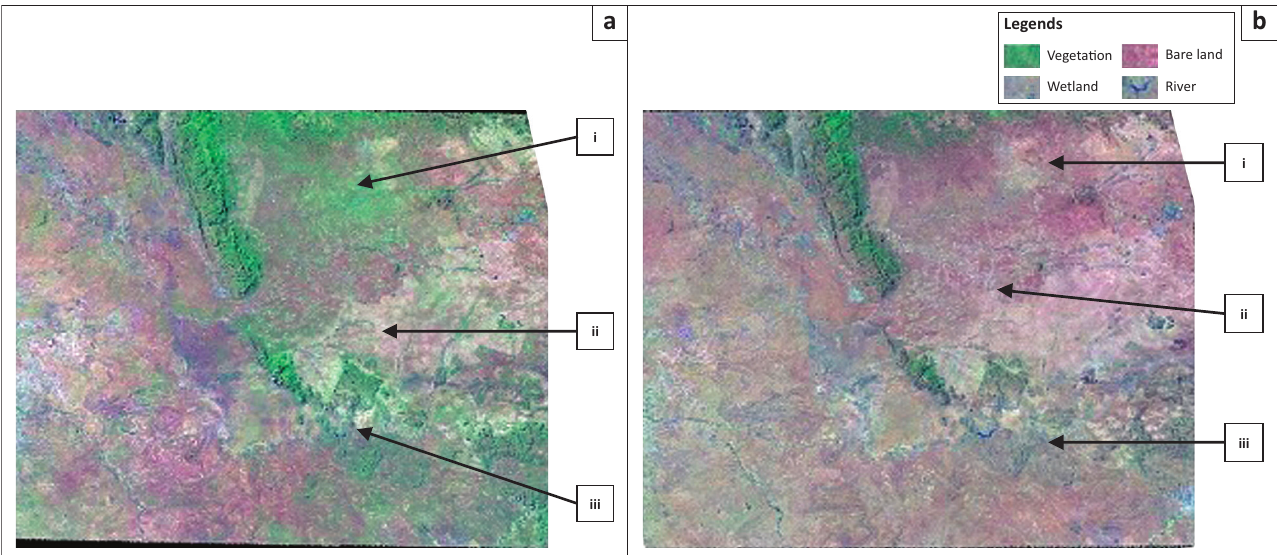
FIGURE 3: Satellite images of land use changes in the study area for (a) 1978 and (b)